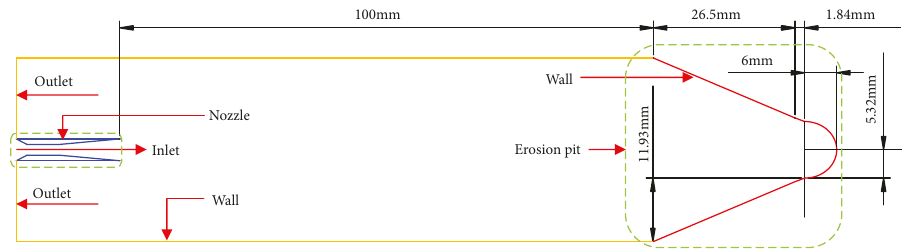
Figure 6: Numerical simulation geometric